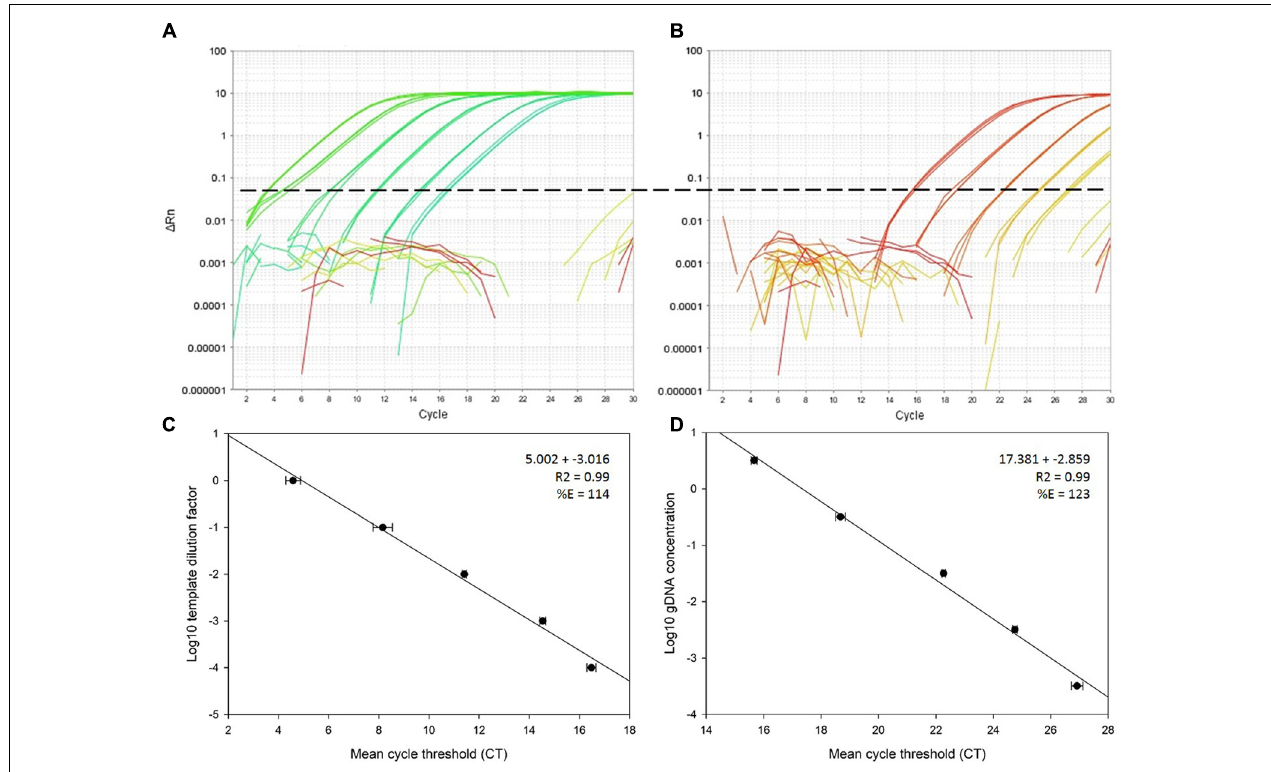
FIGURE 1 | Comparative standard curve analysis of EF4F and EF4R target on a PCR template versus direct amplification of gDNA. Plot (A) shows amplification of diluted PCR template produced from a 10-fold dilution series of Beauveria bassiana gDNA (isolate J18) spiked in Zea mays (maize) gDNA and plot (B) shows direct amplification of a 10-fold dilution series of B. bassiana gDNA (isolate J18) in H 2 O. Plots (C) and (D) show the corresponding standard curves produced from the amplification experiments above, with the regression equation and amplification efficiency